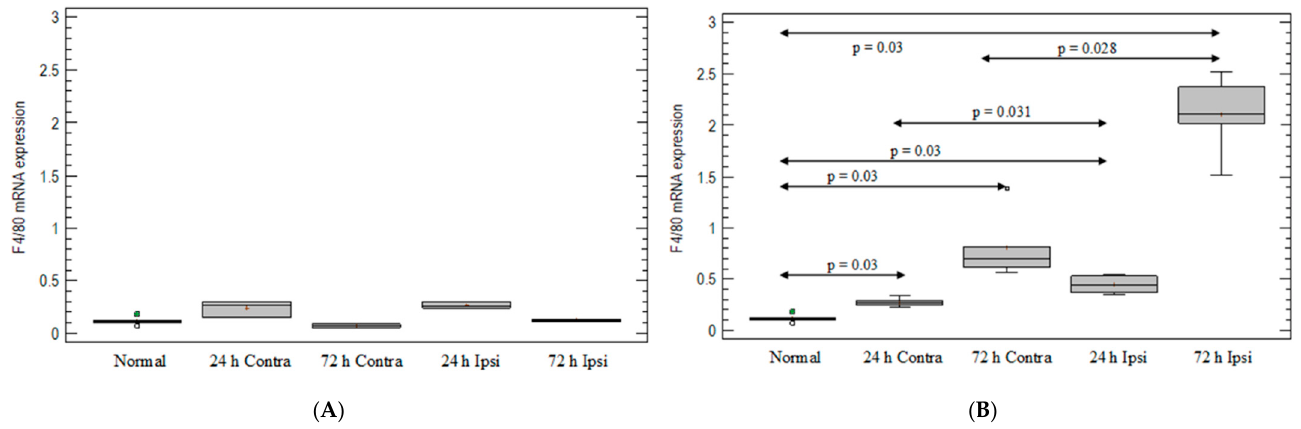
Figure 2. Expression of monocyte-/macrophage-cell-line marker F4/80 in mouse brain after ( A ) PBS injection and ( B ) KA injection. Brains were collected 24 h and 72 h postinjection. Ipsi—ipsilateral hemisphere; Contra—contralateral hemisphere; Normal—control animals without any injection.